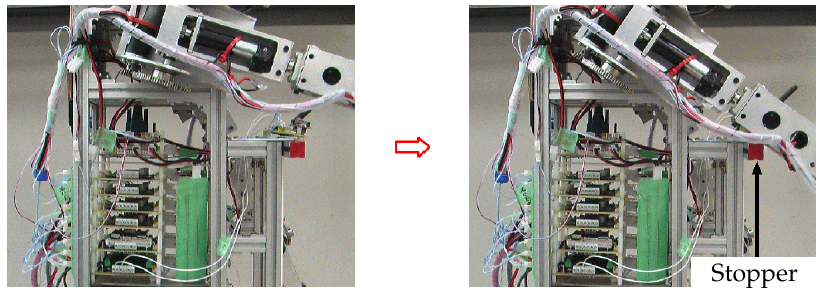
Figure 10. Limit of manipulator rotation when the robot is being pushed